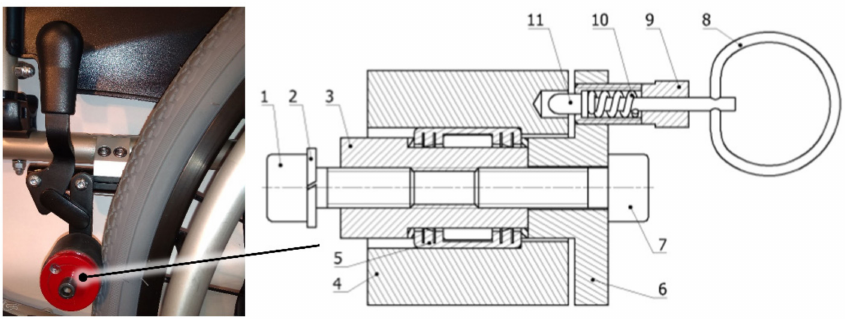
Figure 1. The structure of the anti-rollback system used in the test.